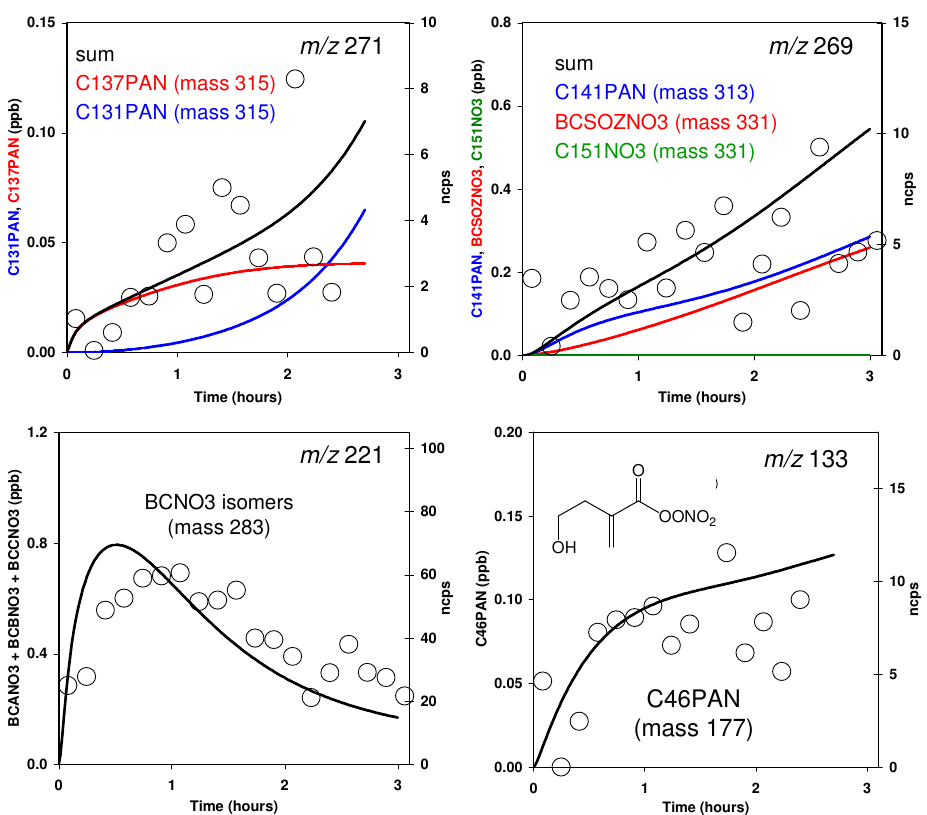
Fig. 18. Example time profiles simulated for multi-functional products containing oxygenated nitrogen groups (lines), compared with those for corresponding product ion signals measured using CIR-TOF-MS (points), during ACES photo-oxidation experiments. Measured signals are presented as normalised counts per second (npcs), for the daughter ions identified in Table 3. Comparisons are for experiments 04-07-08 ( m / z 271 and 133) and 10-07-08 ( m / z 269 and 221). “BCNO3 isomers” is used to denote the collective population of BCANO3, BCBNO3 and BCCNO3.